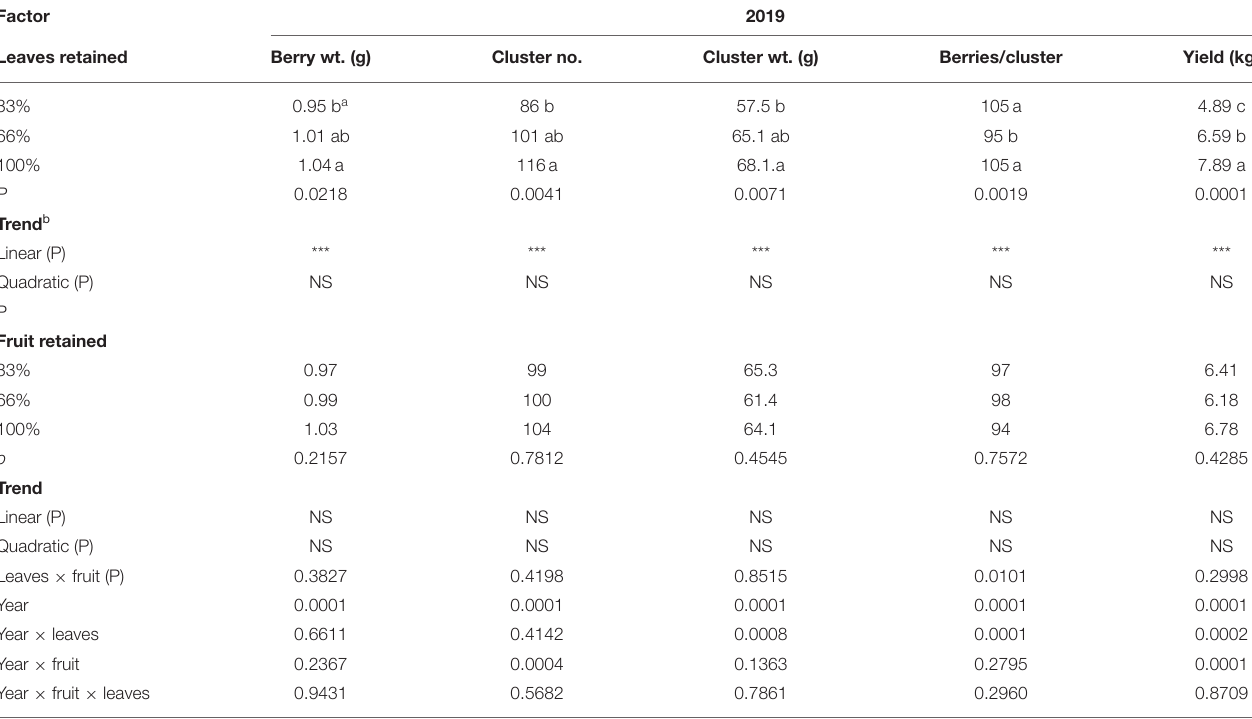
TABLE 2 | Carry-over effects of defoliation and fruit removal on components of yield on Cabernet Sauvignon/110R after two successive seasons.